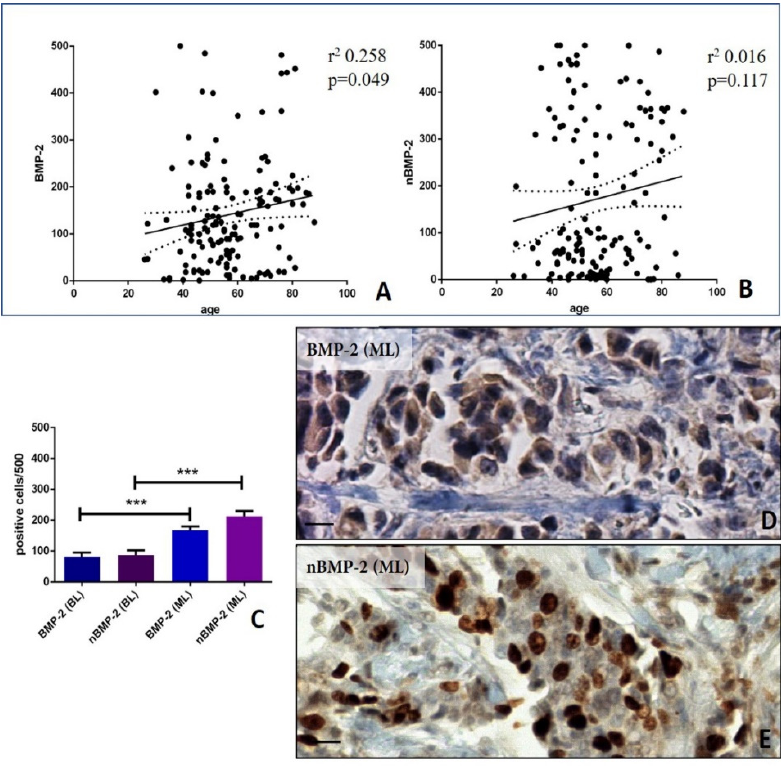
Figure 1. Cytoplasmic and nuclear expression of BMP-2 in breast tissues. ( A ) The graph shows a significant association between the number of BMP-2-positive cells and patients’ age. ( B ) The graph displays a significant association between the number of nBMP-2-positive cells and patients’ age. ( C ) The graph shows the number of positive BMP-2 and nBMP-2 in breast benign and malignant lesions. ( D ) The infiltrating breast carcinomas with numerous cytoplasmic BMP-2-positive cells. ( E ) The infiltrating breast carcinomas with numerous nBMP-2-positive cells. The scale bar represents 200 µ m for each image. (* p ≤ 0.05, ** p ≤ 0.01, *** p ≤ 0.001, **** p ≤ 0.0001).